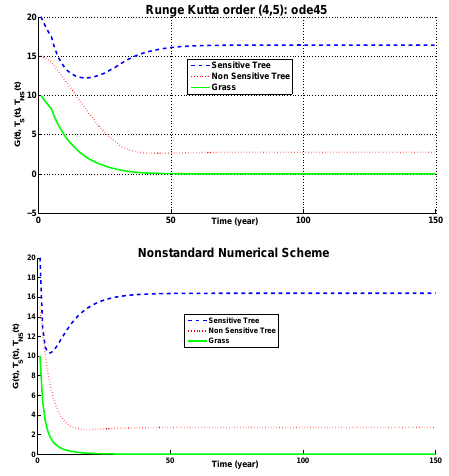
Fig. 11. For these figure, µ G = 0 . 5. The ODE’s routine which is a standard numerical algorithms shows again a spurious negative solutions.